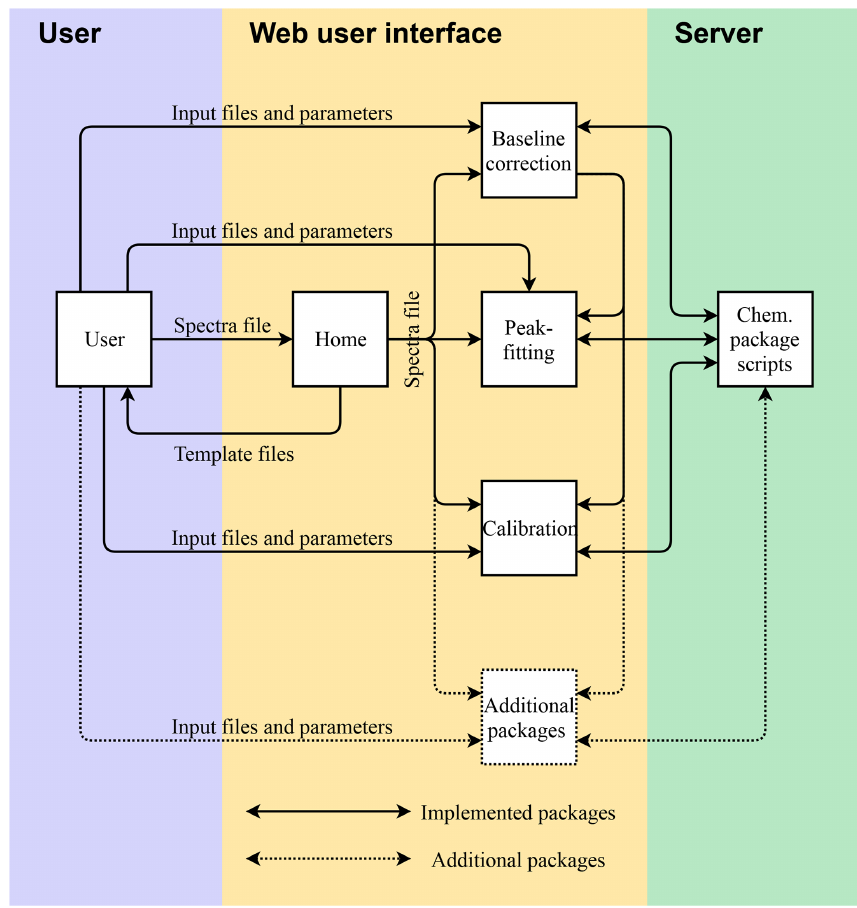
Figure 1. AIRSpec architecture diagram and workflow. Solid boxes and arrows refer to chemometric packages implemented in the current version. Dotted box and arrows denote that it is possible incorporate new packages in the modular